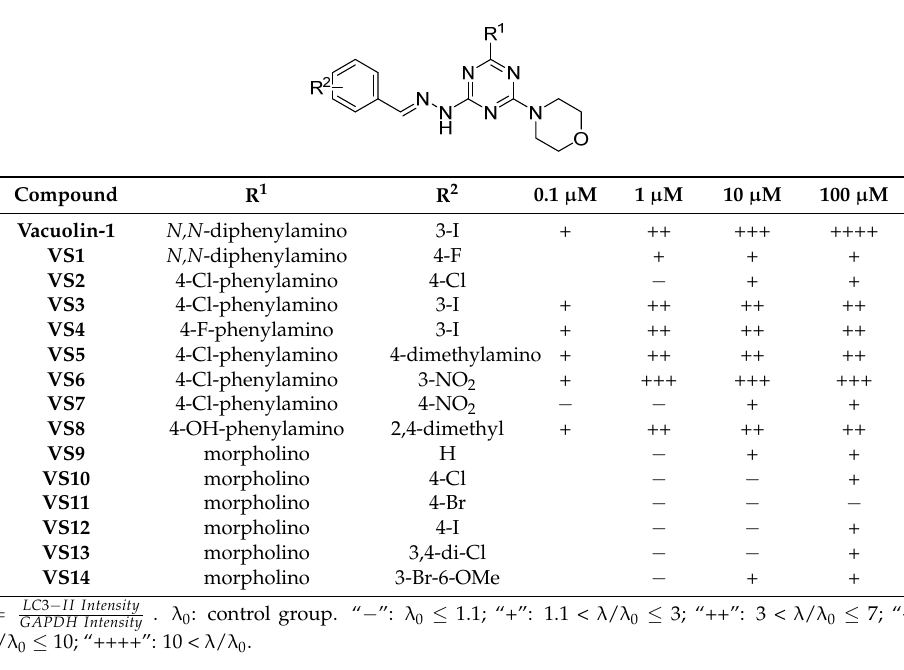
Table 1. Structure-activity relationship (SAR) of selected compounds from virtual screening a .